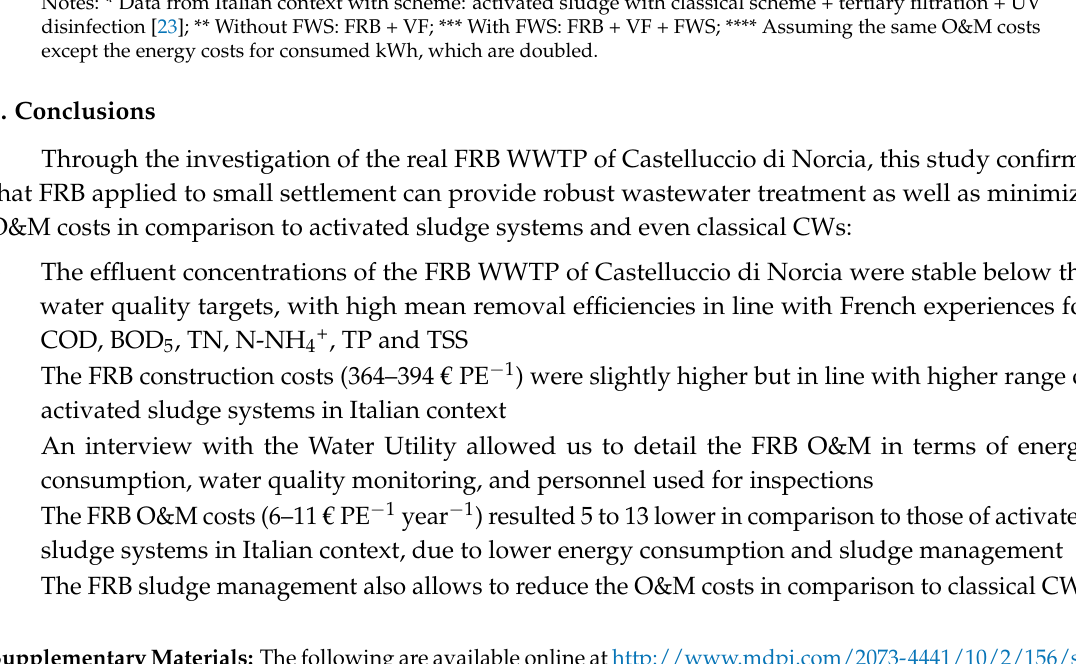
Table S1: Detailed energy consumption and costs at monthly basis for the two year of functioning of the FRB WWTP of Castelluccio di Norcia; Table S2: Calendar of inspections done by Water Utility personnel to the FRB WWTP of Castelluccio di Norcia; Table S3: Calendar of water quality sample done by Water Utility personnel to monitor the FRB WWTP of Castelluccio di